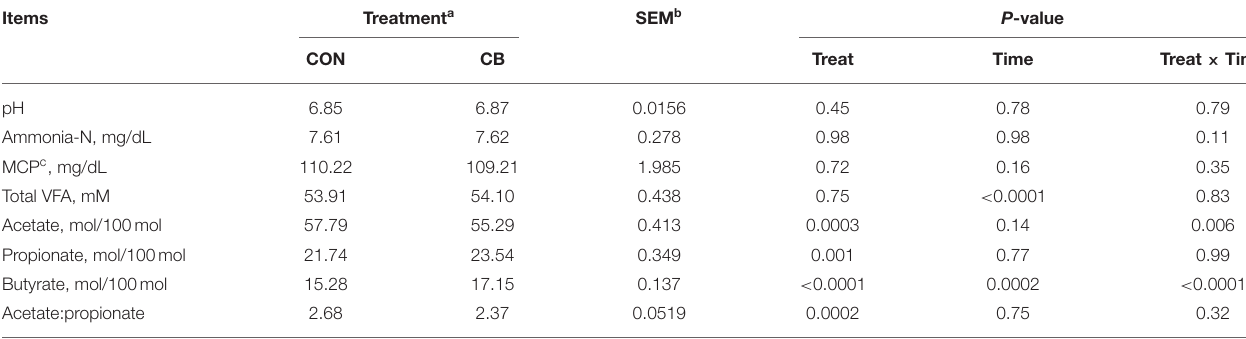
TABLE 5 | Effect of Clostridium butyricum on ruminal fermentation in heifers. Items